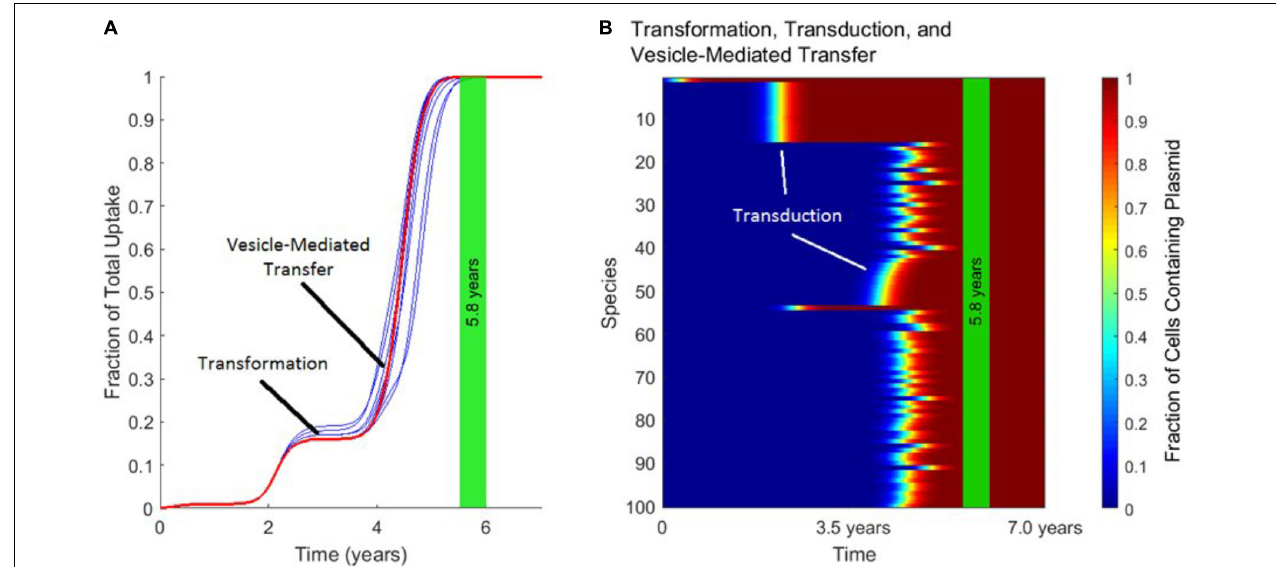
FIGURE 5 | The timescales of transformation, transduction, and vesicle-mediated transfer. In each panel, the vertical green stripe marks the mean time that the plasmid achieved full spread, plus and minus one standard deviation, for 10 repetitions of the simulation. Full spread is defined as at least 99% plasmid uptake in every bacterial species. Full spread occurred after 5.8 ± 0.2 years. (A) The overall uptake of the plasmid over time for 10 runs of the simulation in the absence of conjugation. The approximate times at which transformation and vesicle-mediated transfer introduce the plasmid to new species are marked. Transduction continually spread the plasmid within each phage-host module throughout the simulation. (B) The per-species dynamics of the run marked in red in (A) . The first two phage-host modules in which the plasmid spread widely via transduction are